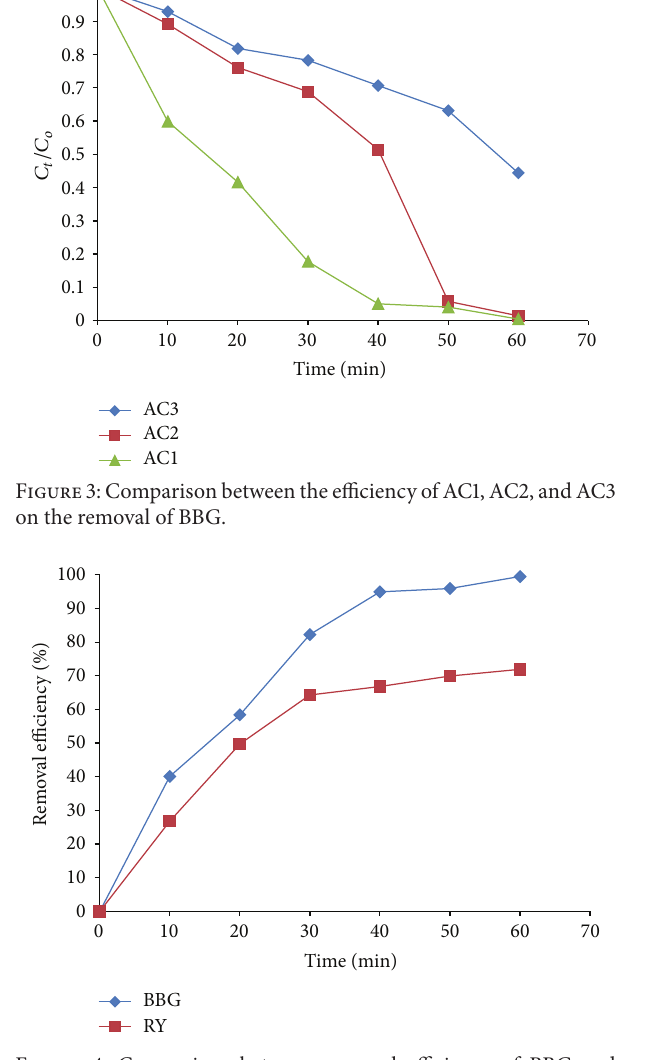
Figure 4: Comparison between removal efficiency of BBG and RY145 dyes on